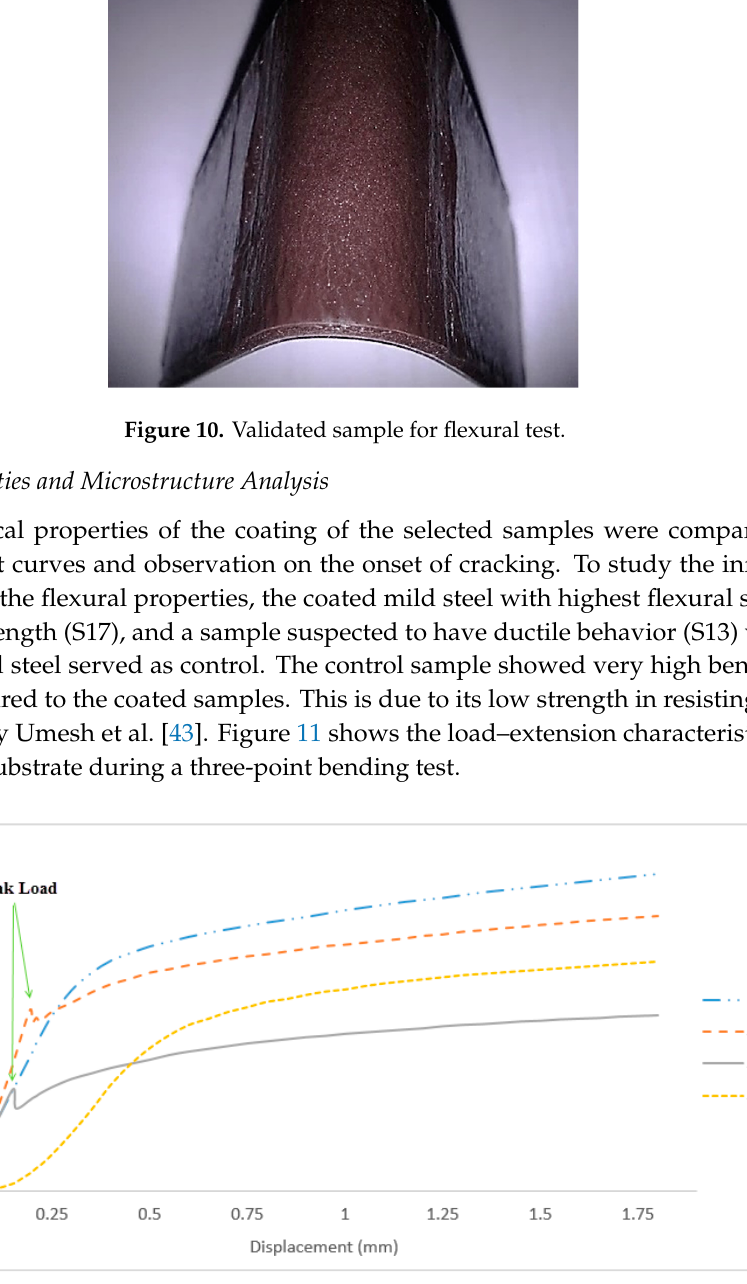
Figure 11. Load–extension (displacement) characteristics of samples during three-point bending tests: (i) substrate without coating; (ii) S14; (iii) S13; and (iv) S17.